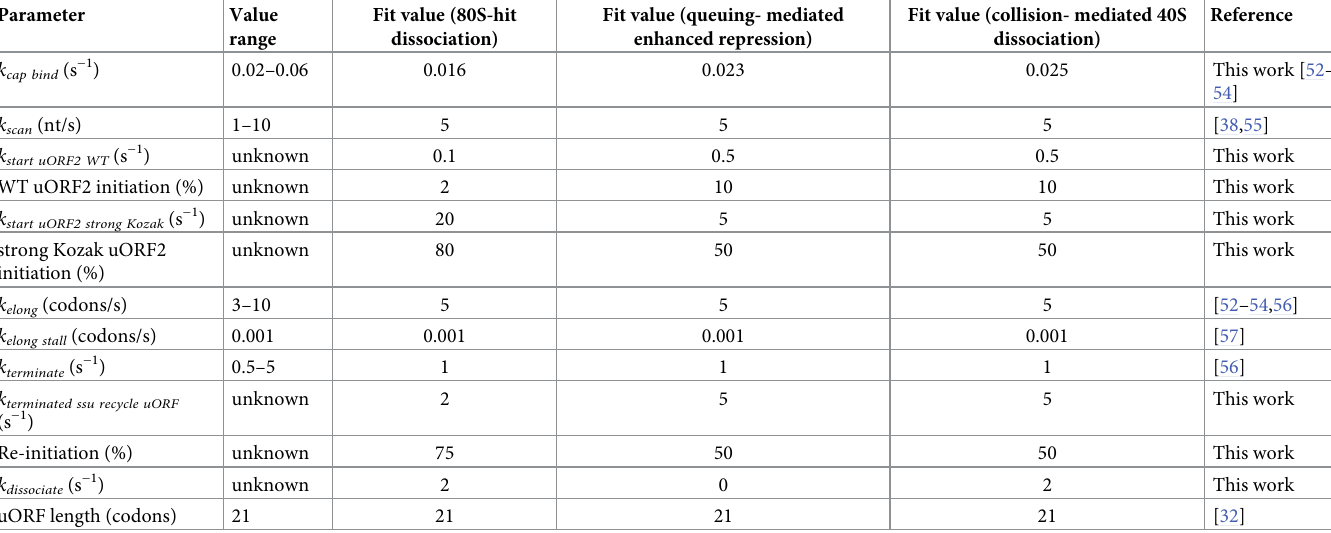
Table 1. Parameter ranges and fit values for